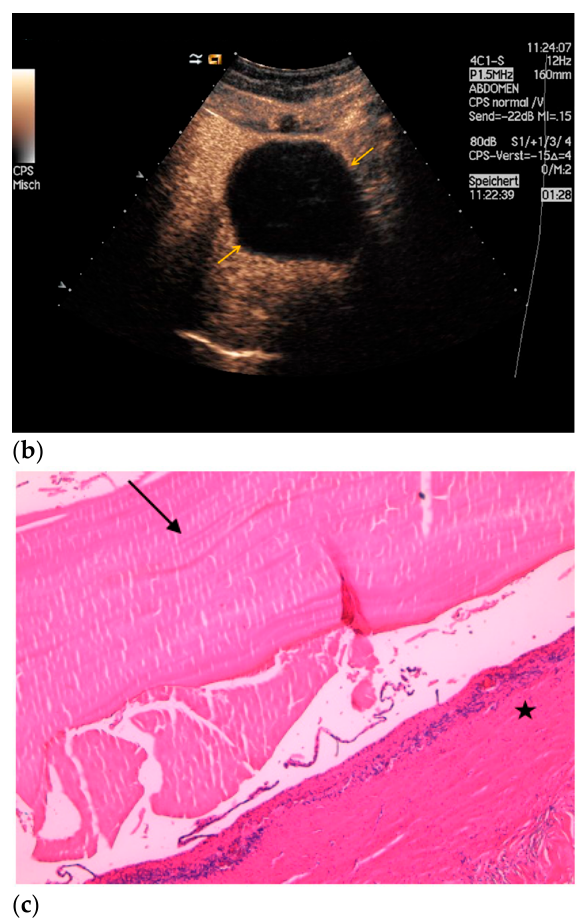
Figure 2. 34-year-old patient with an echinococcal cyst in liver segments II/III. ( a ) Native B-mode ultrasound reveals an inhomogeneous cystic lesion in the left liver lobe (yellow arrows). ( b ) In contrast-enhanced ultrasound, no enhancement of the cystic lesion is detected (yellow arrows, portal venous phase). Sonomorphological differentials included haemorrhagic cyst or cystic echinococcosis. The sonomorphological appearance in combination with positive serological findings confirmed the diagnosis of cystic echinococcosis. After interdisciplinary evaluation, the patient underwent laparoscopic resection of the liver segments II and III. ( c ) Hematoxylin and Eosin staining of the echinococcal cyst, 50× magnification. The fibrous tissue (pericyst, black star) surrounding the cuticula (black arrow) is shown.